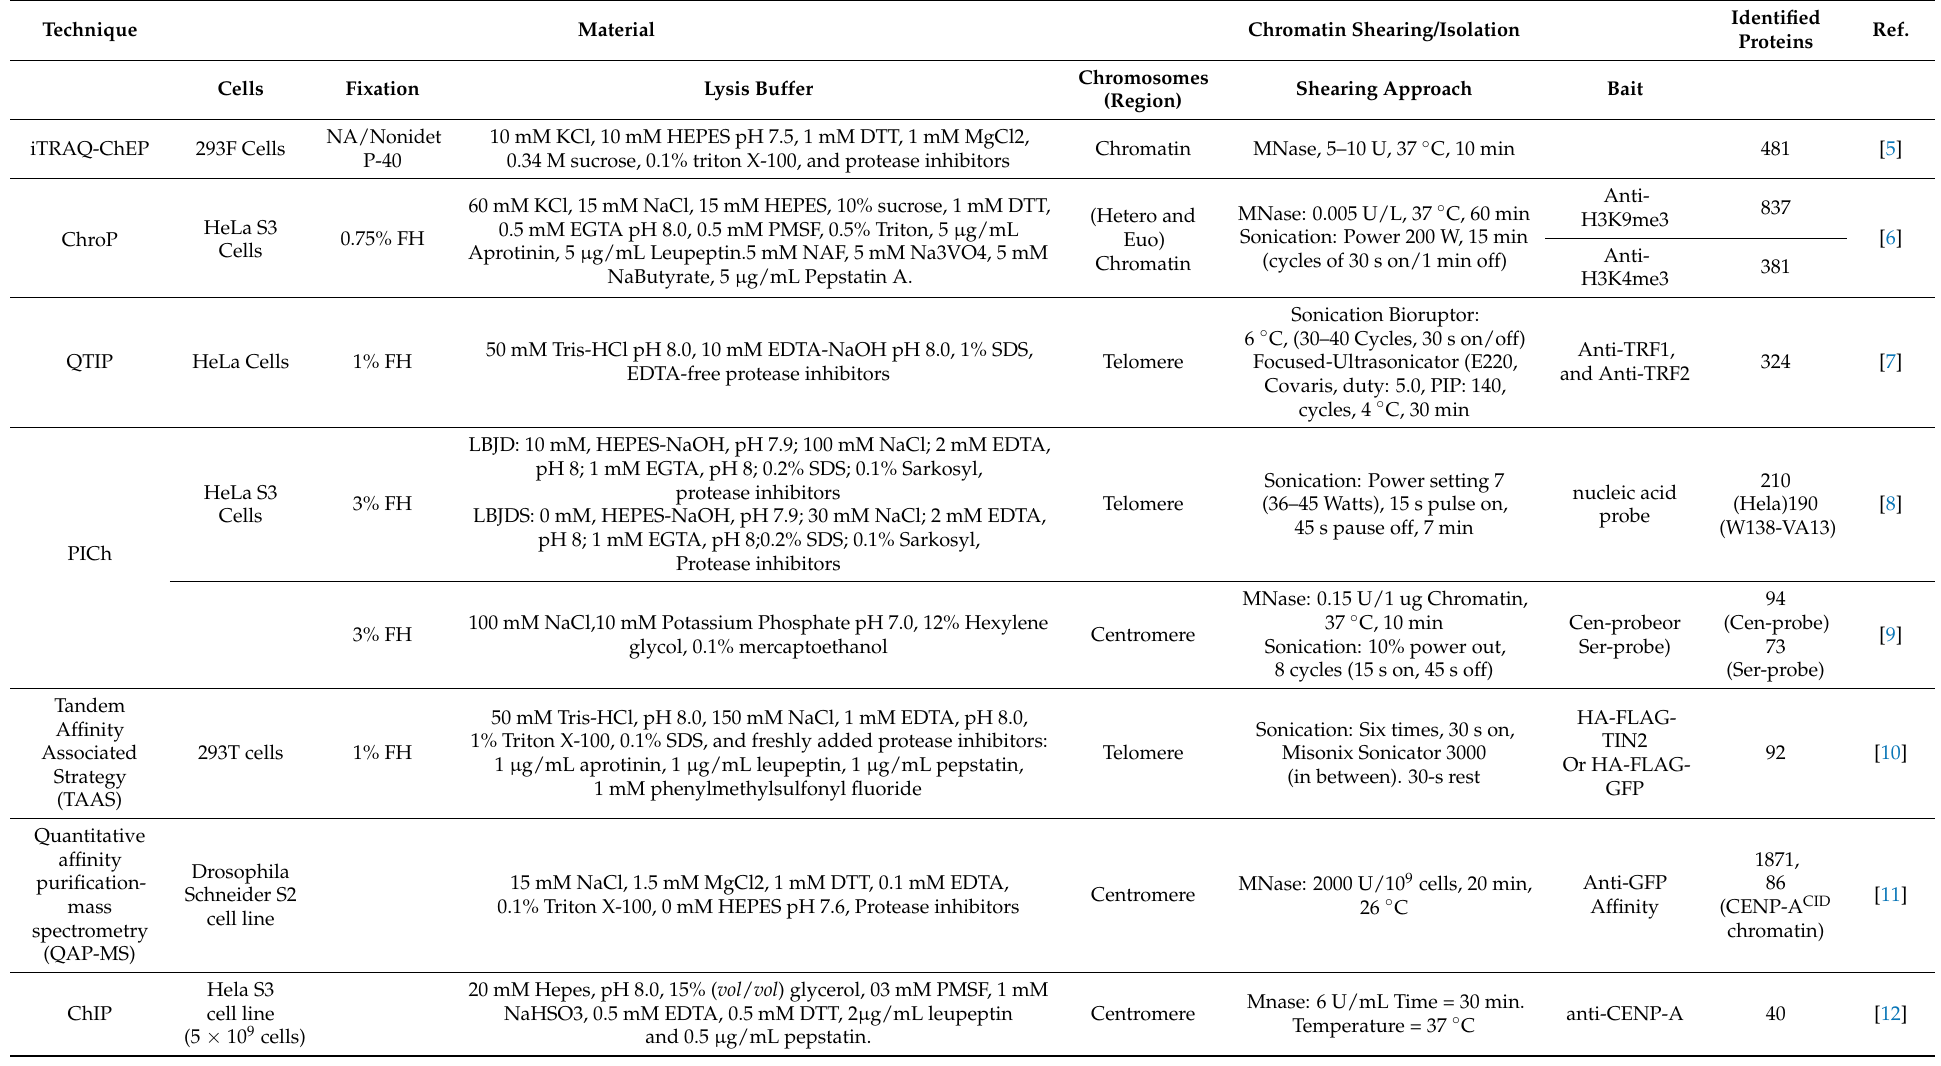
Table 1. Approaches to identify specific chromatin locus associated